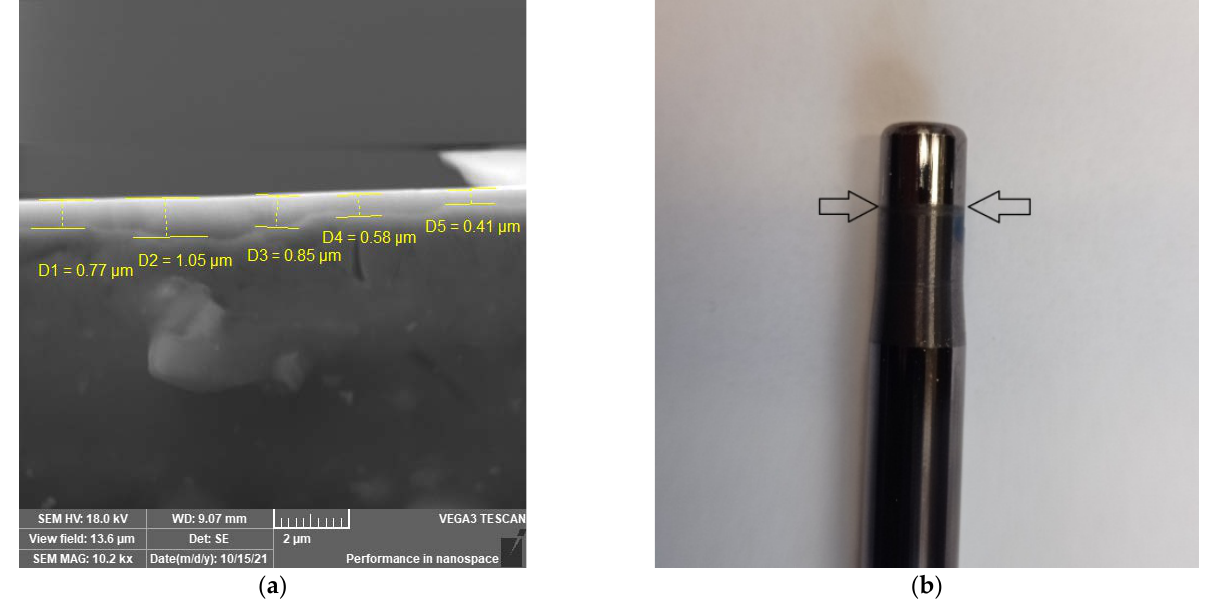
Figure 16. SEM image of the delaminated layer ( a ) and place of deepest tool damage ( b ).